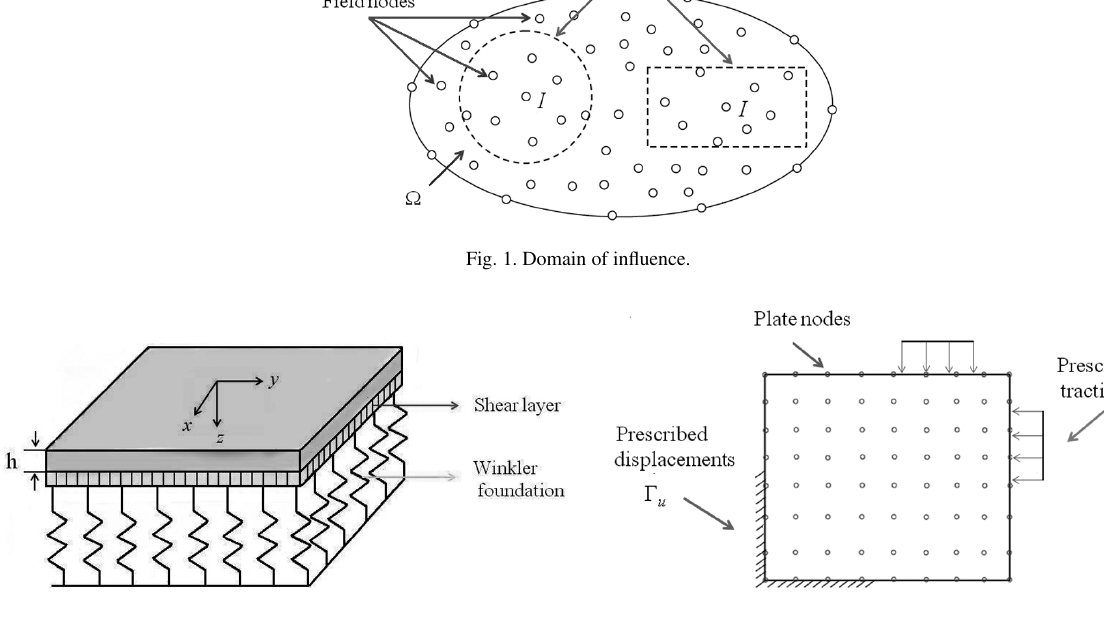
Fig. 3. Prescribed boundary